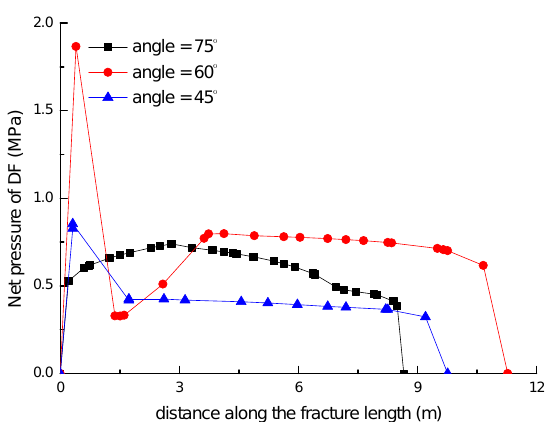
Figure 18. The net pressure curves of the DF along the fracture length direction at different levels of intersection angle between HF and NF. The distance in the x -axis is along the direction from the lower part to the upper part of the DF.